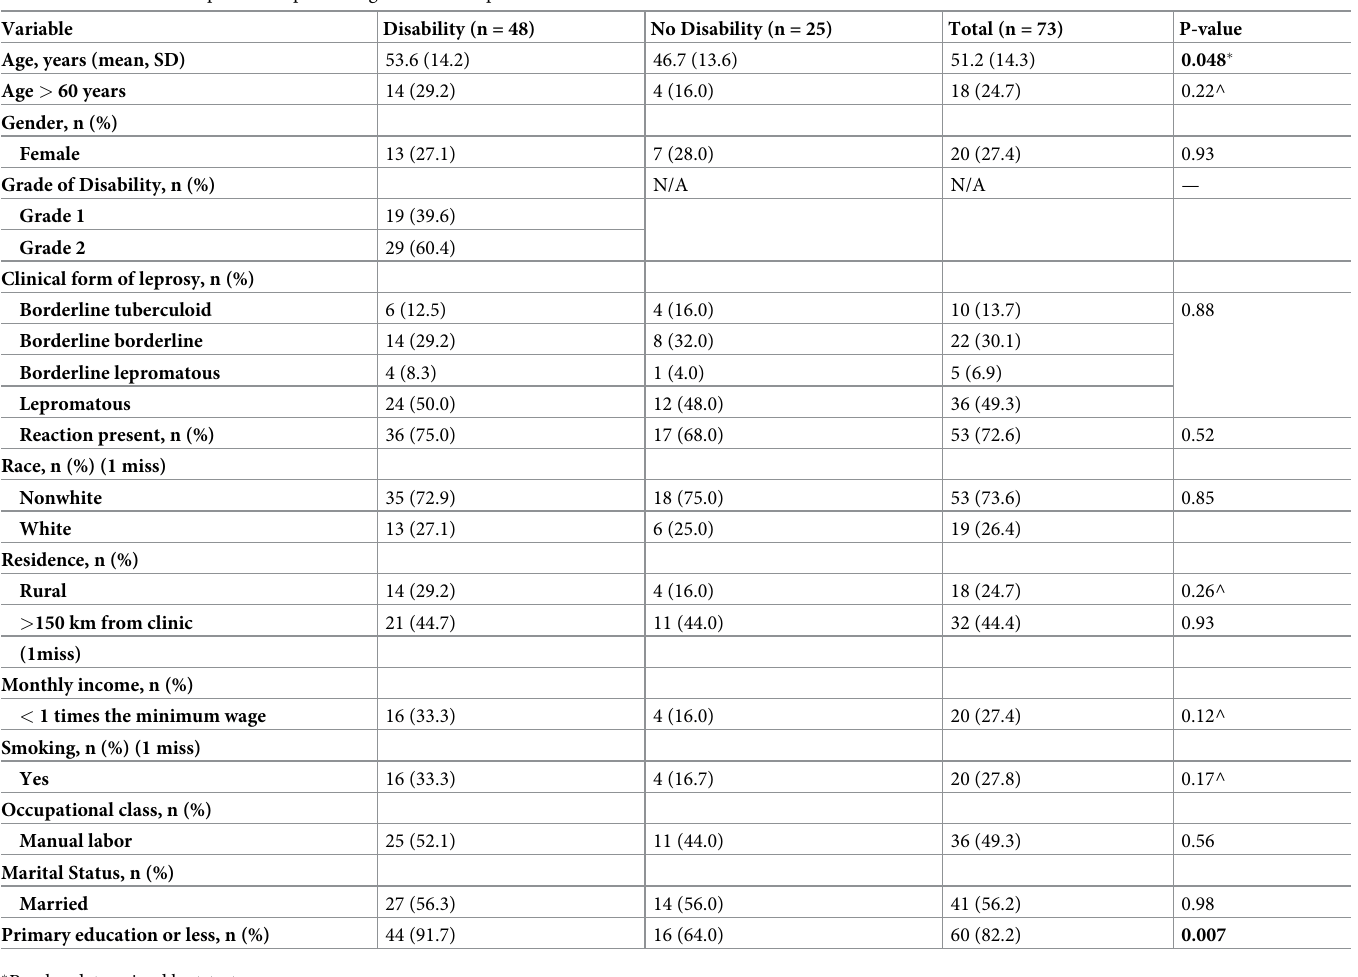
Table 2. Main demographic and clinical variables of study population, comparing those with and without disability on univariate analysis, using chi-square unless otherwise noted. Bolded p-values represent significance at a p-value < 0.05. Variable Disability (n = 48) No Disability (n = 25) Total (n = 73) P-value Age, years (mean, SD) 53.6 (14.2) 46.7 (13.6) 51.2